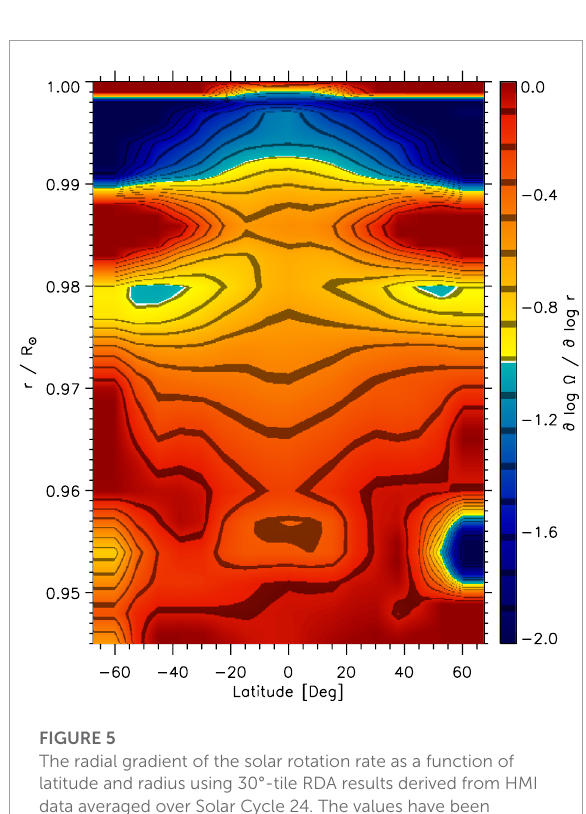
FIGURE 5 The radial gradient of the solar rotation rate as a function of latitude and radius using 30°-tile RDA results derived from HMI data averaged over Solar Cycle 24. The values have been interpolated on an equidistant grid in radius and onto the 7.5° grid in latitude used by 15°-tile